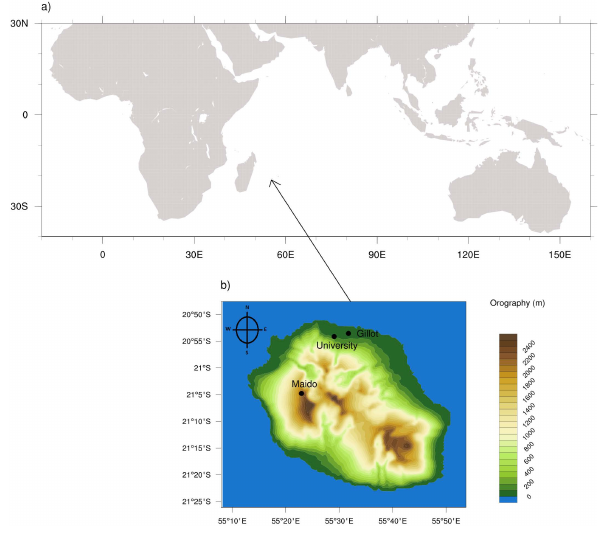
Fig. 1. Maps showing the locations of Reunion Island in the Indian Ocean (a) and of the different measurement sites, Maïdo facility, Gillot, and University in Reunion Island (b) .